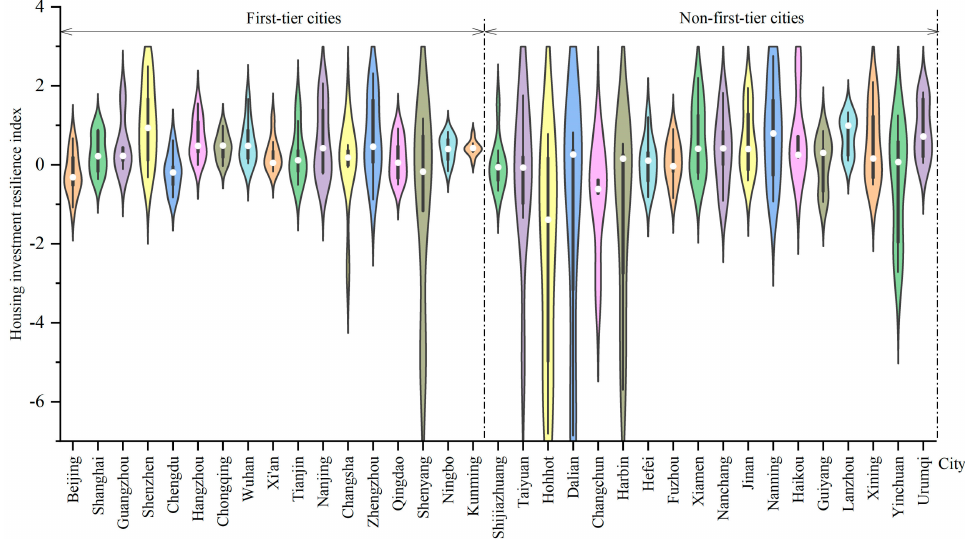
Figure 4. Evolution of housing investment resilience in 35 large and medium-sized cities,